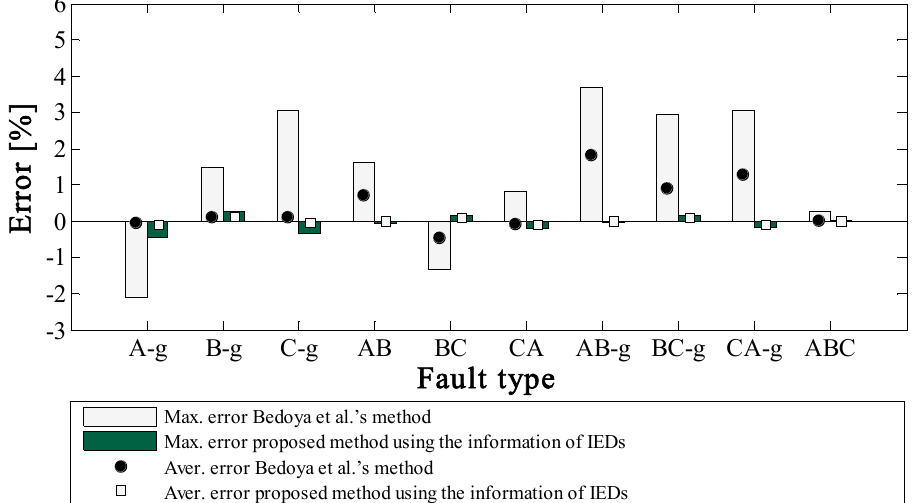
Figure 16. Fault error comparison: Bedoya et al.’s method [21] and proposed formulation using the information of IEDs.